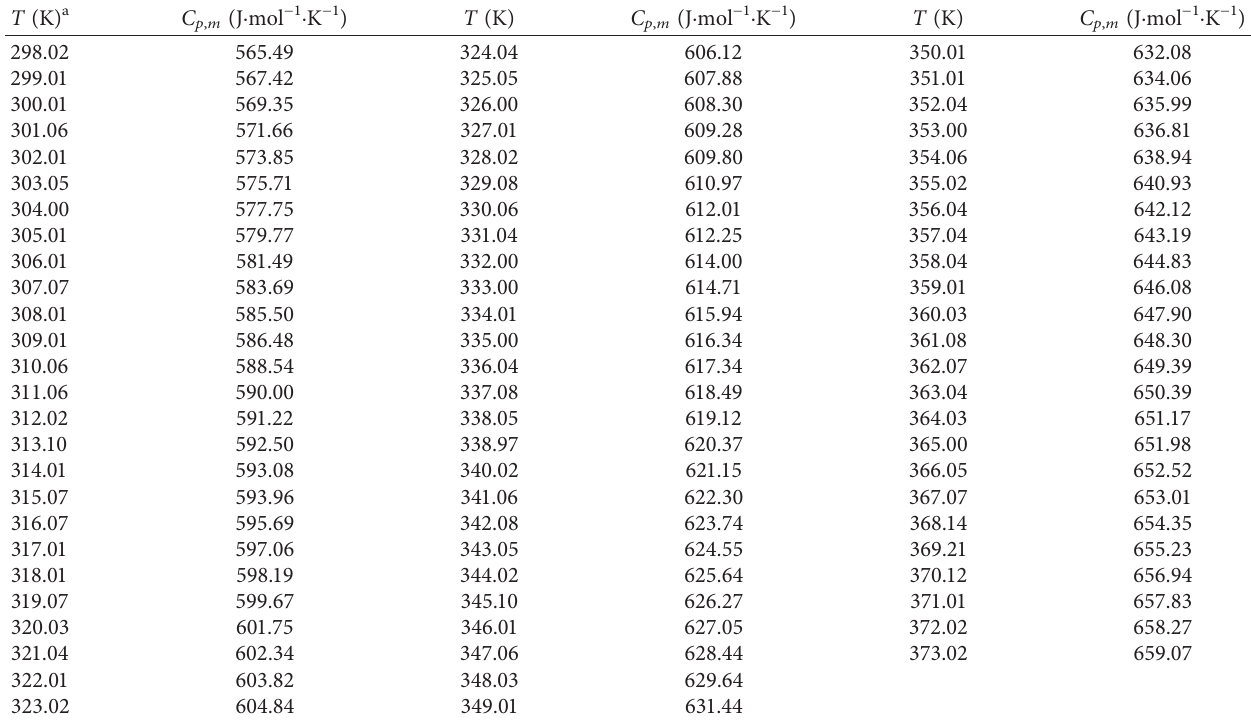
· 4H 5 O 8 2 O (molecular mass M